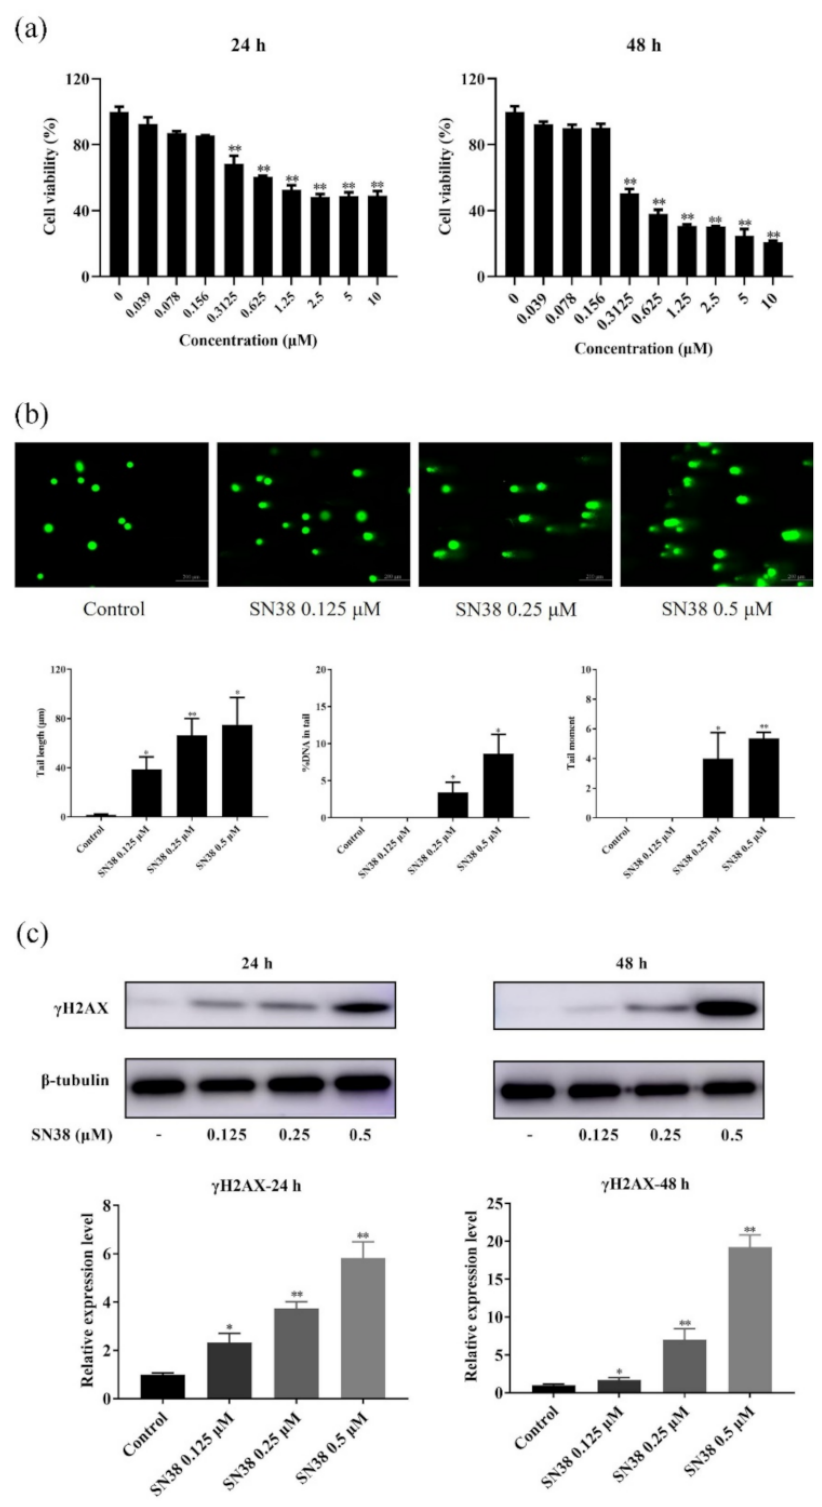
Figure 1. ( a ) Effects of SN38 treatment (0–10 µ M) on cell survival of HCT 116 cells for 24 and 48 h, respectively; ( b ) Photographs of DNA comets and image analysis of the comet assay in HCT 116 cells treated with SN38; ( c ) Expression of γ H2AX in Western blot assay. Note: * p < 0.05, ** p < 0.01, SN38-treated group vs. control